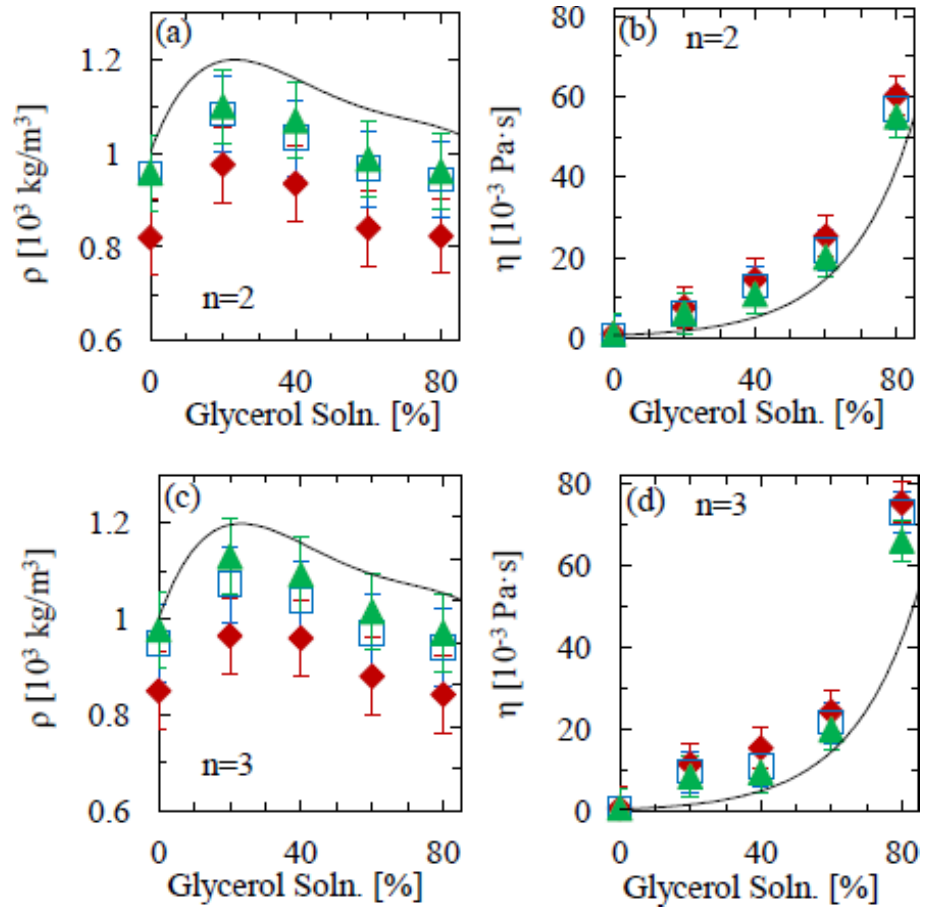
Figure 3. ( a ) Mass density and ( b ) viscosity of water-glycerol mixtures, as a function of glycerol volume percentage, determined from the second mode (n = 2) of flexural cantilever oscillation. ( c ) and ( d ) show the corresponding results for the third mode (n = 3) of oscillation. The solid line denotes the literature values [24] at 20 °C. Triangles,